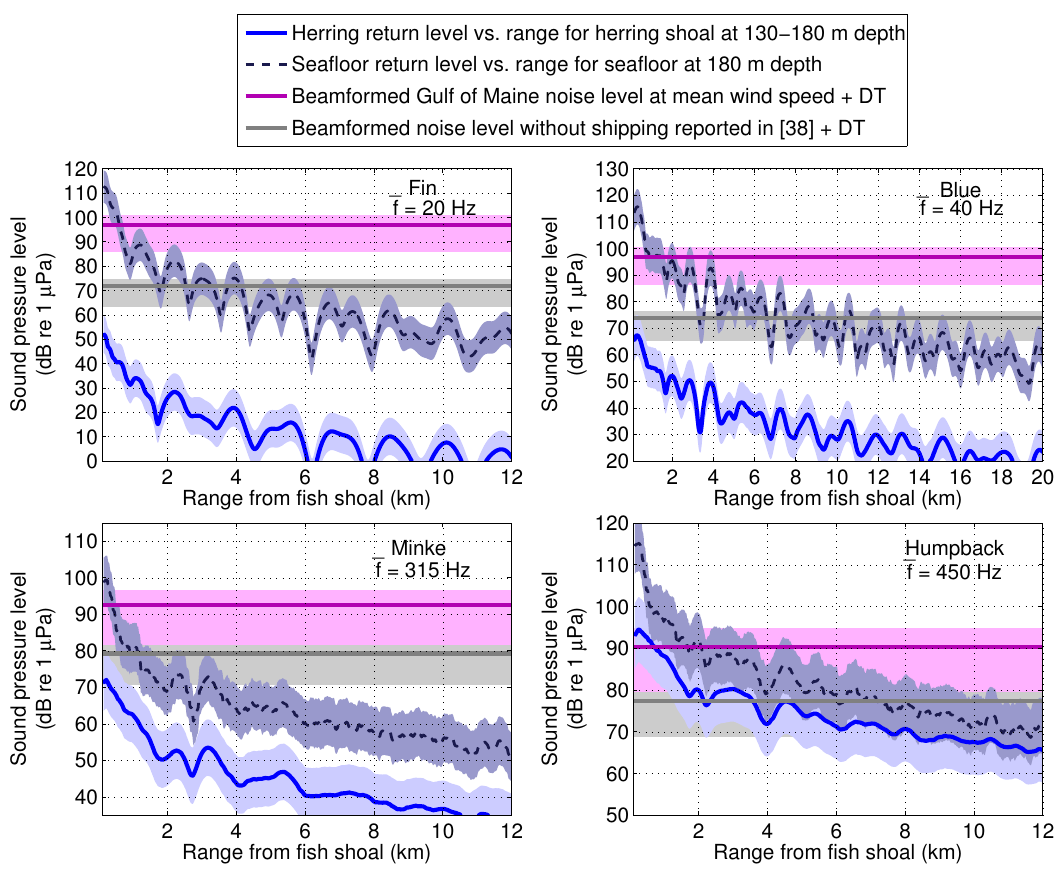
Figure 5. Detections of herring shoals at depths of 130–180 m (blue solid lines) are found to be unfeasible for the parameters of any baleen whale considered. Detections of the seafloor are found to be feasible up to 2 ± 1 km in range for blue and humpback parameters and roughly 1 km for fin and minke parameters over local ambient noise. Dark blue dashed lines represent seafloor scattering for a seafloor depth of 180 m. Purple solid lines represent the beamformed ambient noise levels with mean wind speed of 5.6 m/s during peak herring spawning period in the Gulf of Maine with one detection threshold ( DT ) added. Light purple shaded areas range from the beamformed ambient noise levels at 2 m/s wind speed minus 5.6 dB to those at 10 m/s wind speed plus 5.6 dB, to illustrate the typical range of wind-speed-dependent ambient noise encountered. Gray solid lines represent the beamformed ambient noise level without significant shipping with wind speed of 5.1 m/s [38] with one DT added. Light gray shaded areas range from beamformed ambient noise levels without significant shipping at 5.1 m/s wind speed plus/minus the instantaneous intensity standard deviation of 5.6 dB. The beamformed ambient noise levels are determined for frequency bands of baleen whale vocalizations given in Table 1 using Equations (9) and